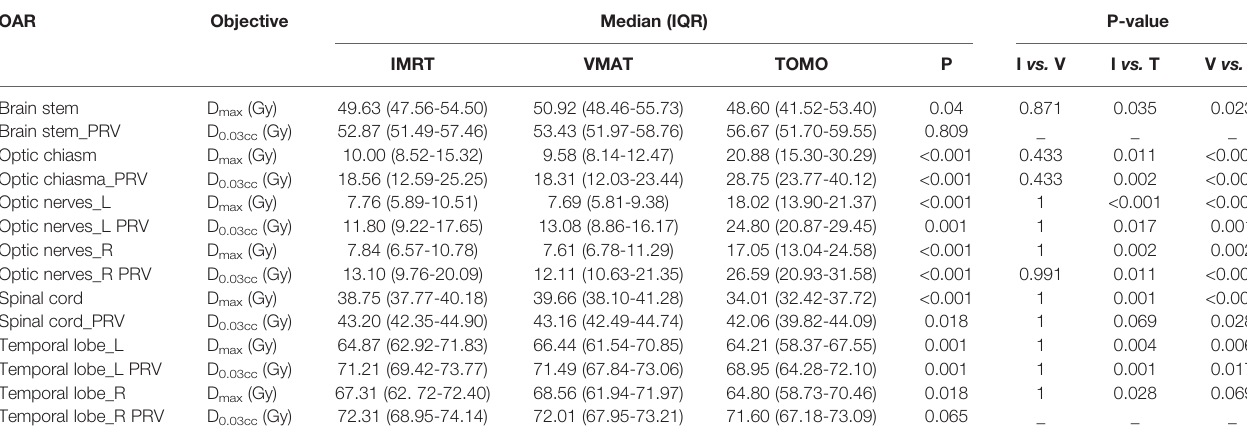
TABLE 6 | Comparison of organs at risk (priority level I and II) in T 1-2 NPC patients.